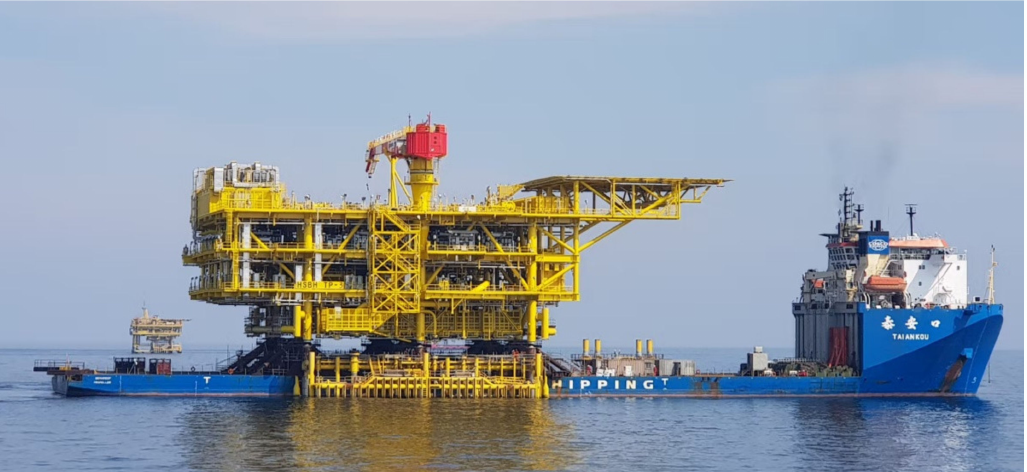
Figure 12. Jacket platform topside being transported floatover installation towards platform integra- tion (Courtesy: Saudi